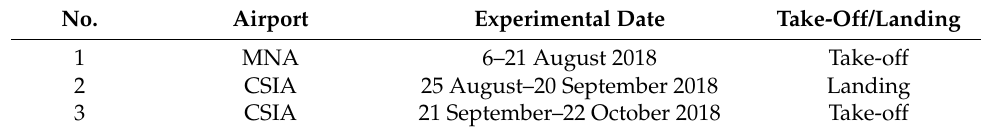
Figure 1. Wake vortex observation experiments ( a ) for the take-off phase at Mianyang Nanjiao Airport (MNA), ( b ) for the landing phase at Chengdu Shuangliu International Airport (CSIA), and ( c ) for the take-off phase at CSIA. Table 1. The experimental information for wake vortex observation experiments (WVOEs).